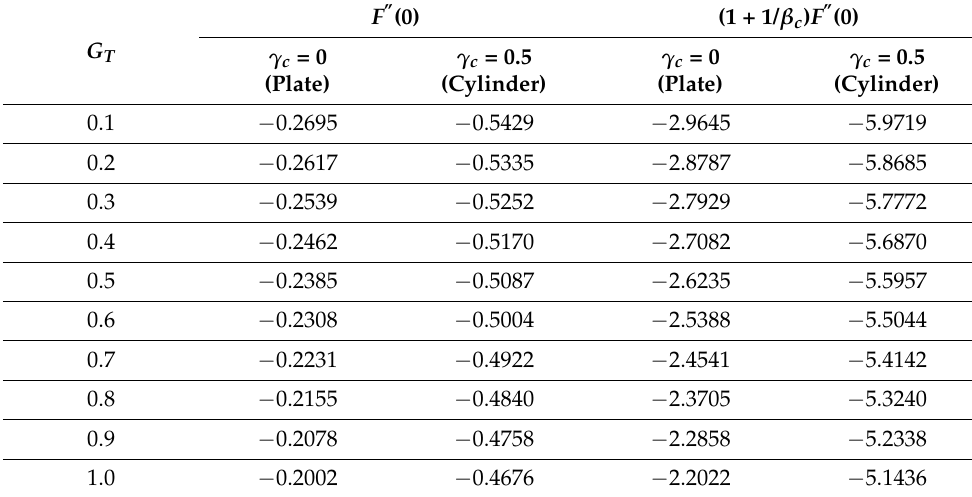
Table 10. Variation in SFC for G T when M p = 0